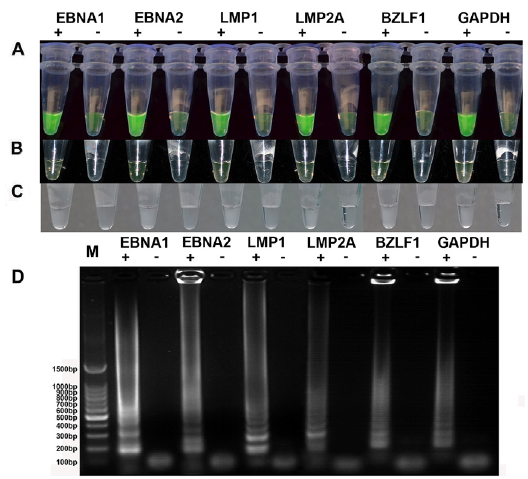
Figure 1. Analysis of RT-LAMP reaction products after amplification. M, 100 bp DNA ladder; +, positive; − , negative. Visual detection was performed using the color change from brown to fluorescent green under UV light. ( A ) A reaction was considered positive if fluorescent calcein dye was detected; ( B ) If the color changed from brown to green in normal light; ( C ) Or if turbidity from the white precipitate was observed; and ( D ) When analyzed by agarose gel electrophoresis, positive RT-LAMP products exhibited a ladder-like